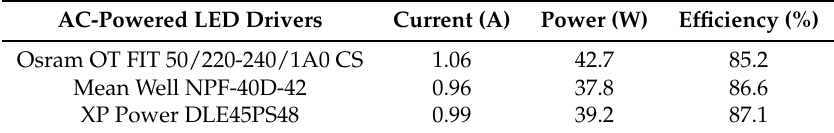
Table 1. Operating current, power and efficiency results of the AC-powered LED drivers.